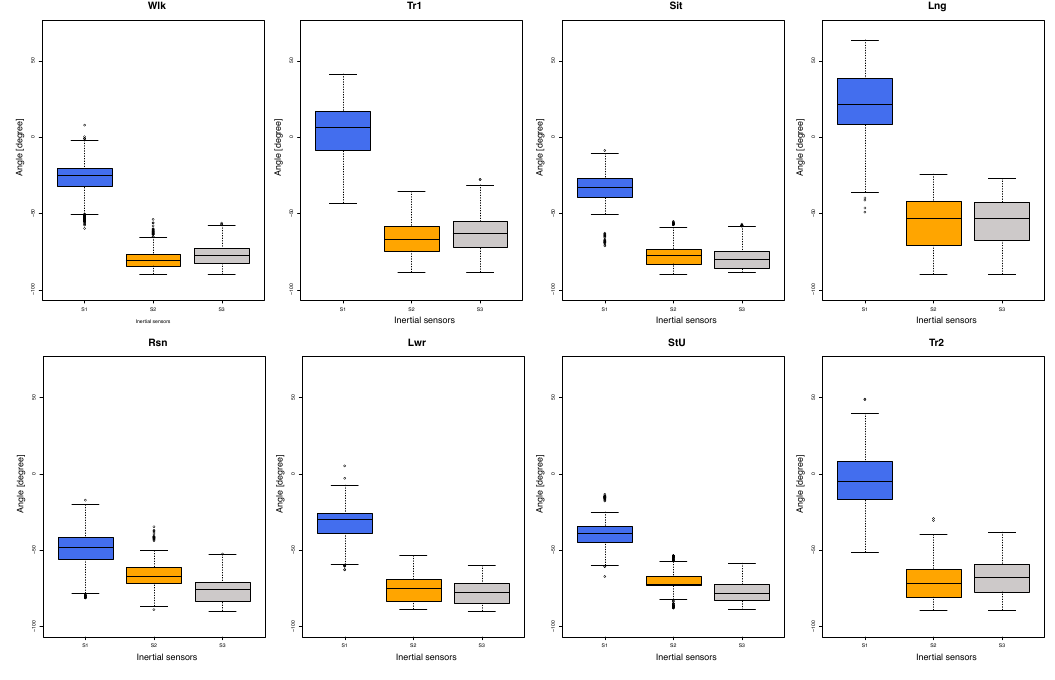
Figure 4. Distribution of data on the x -axis for each sensor during the monitoring of torsos while residents carry out specific